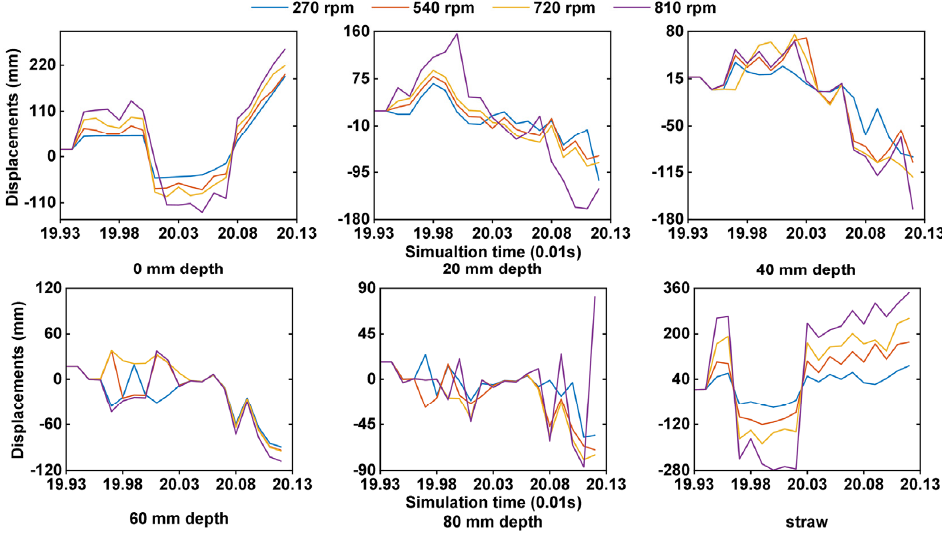
Figure 10. Lateral displacements of soil particles at di ff erent depths and surface straws at di ff erent rotary speeds.